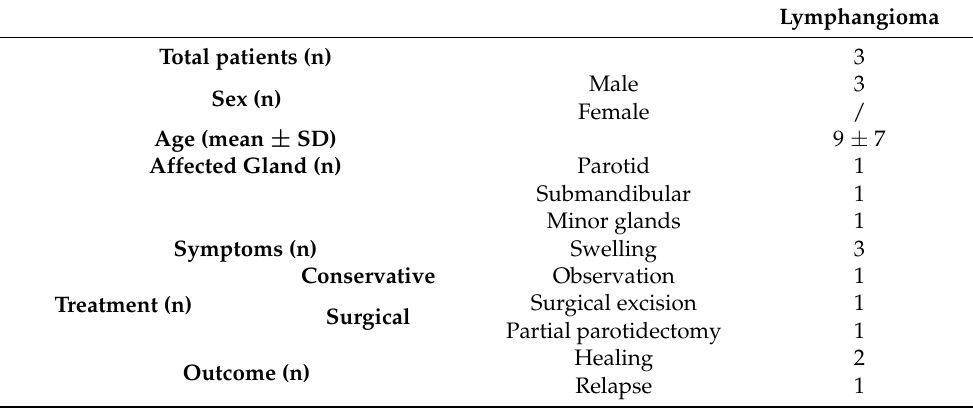
Table 4. The malformative